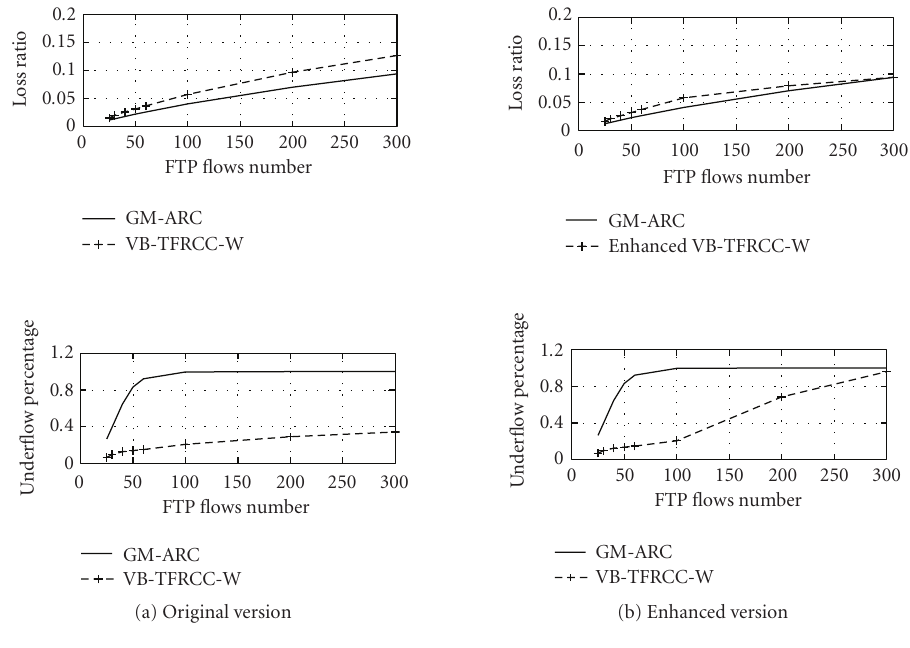
Figure 11: Performance evaluation for the enhanced